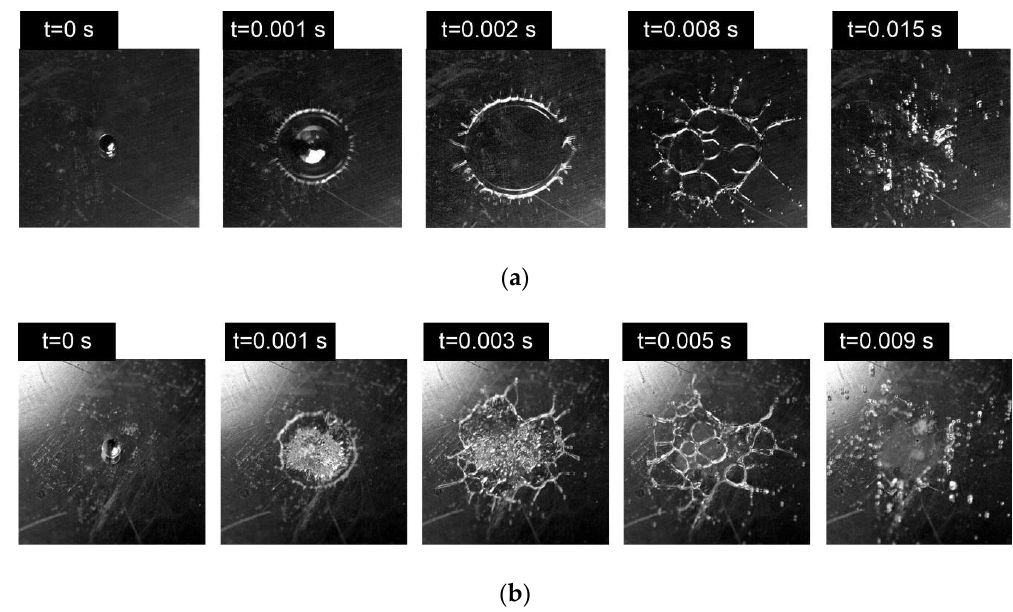
Figure 6. WiBDME drop hydrodynamic breakup regimes: ( a ) film boiling breakup, C-1, T 0 = 500 °C, D 0 = 2.9 mm, U 0 = 3 m/s; ( b ) transient boiling breakup, C-1, T 0 = 300 °C, D 0 = 2.9 mm, U 0 = 3 m/s.